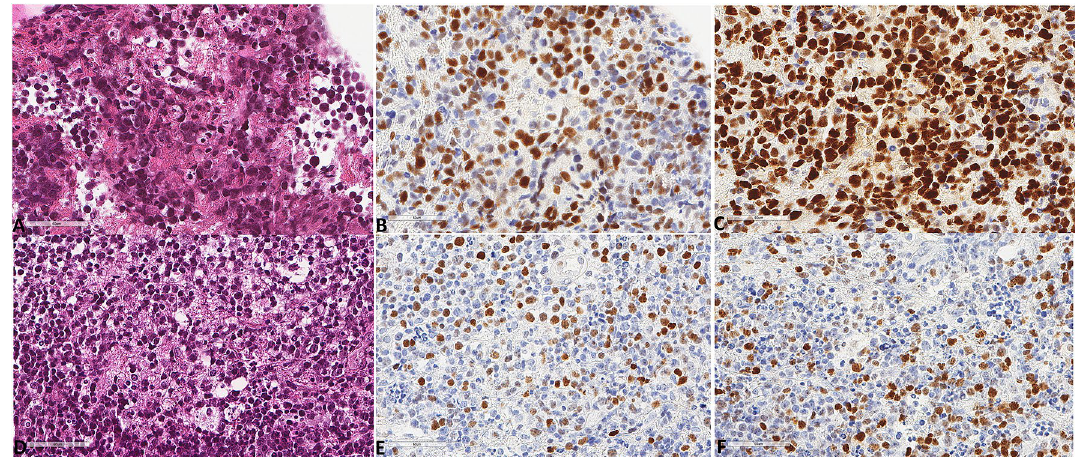
Figure 1. Representative microscopic images of two different PCNSLs diagnosed in two patients with MSKCC score C. All magnifications correspond to × 400 and represent the same focus between the morphological and